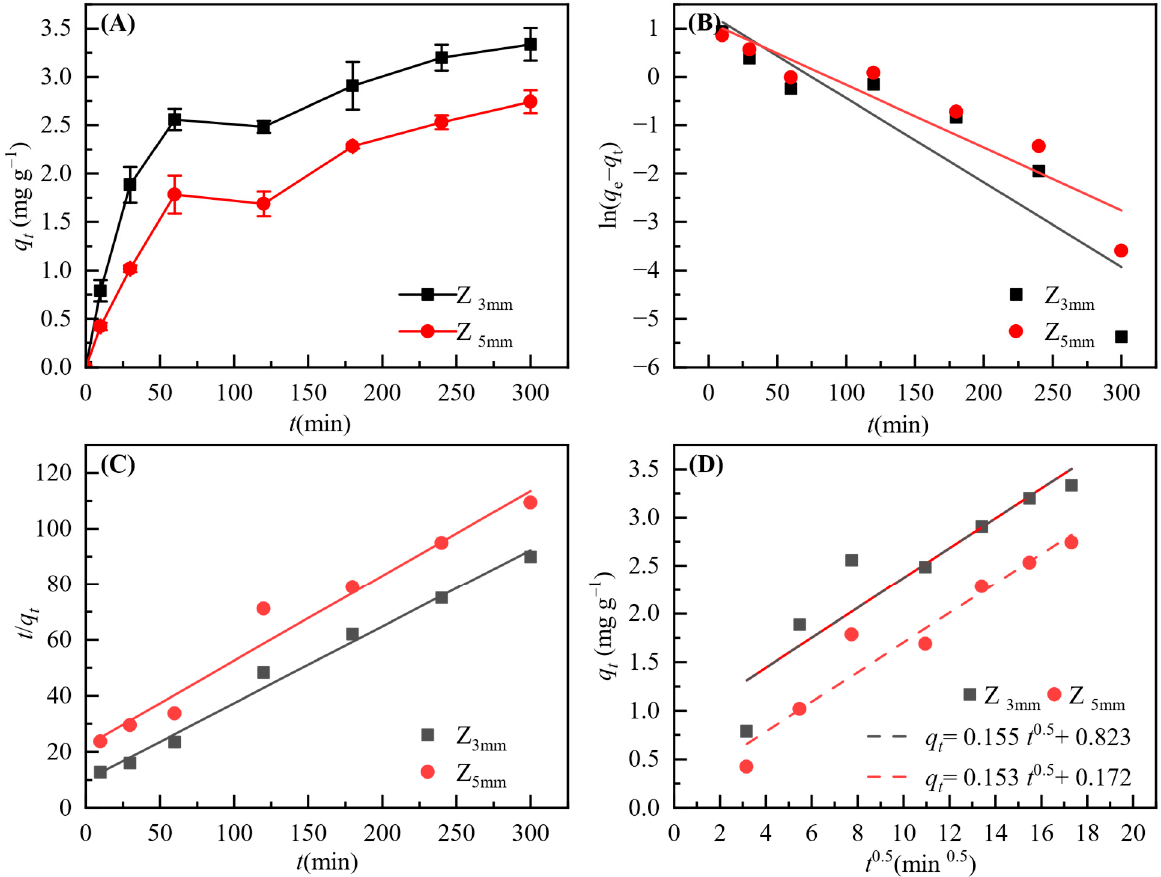
Figure 4. Nitrogen (N) adsorption kinetics in a drainage ditch simulation using two particle sizes of zeolite. ( A ) N adsorption over time. ( B ) Pseudo-first-order kinetic model and ( C ) pseudo-second- order kinetic model of N adsorption on zeolite. Red circles indicate 5 mm zeolite particles; black squares indicate 3 mm zeolite particles. ( D ) Fitness of the intraparticle diffusion model using the Morris–Weber